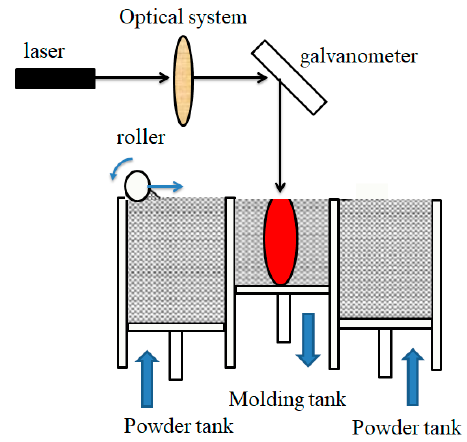
Figure 6. Working scheme of SLS.